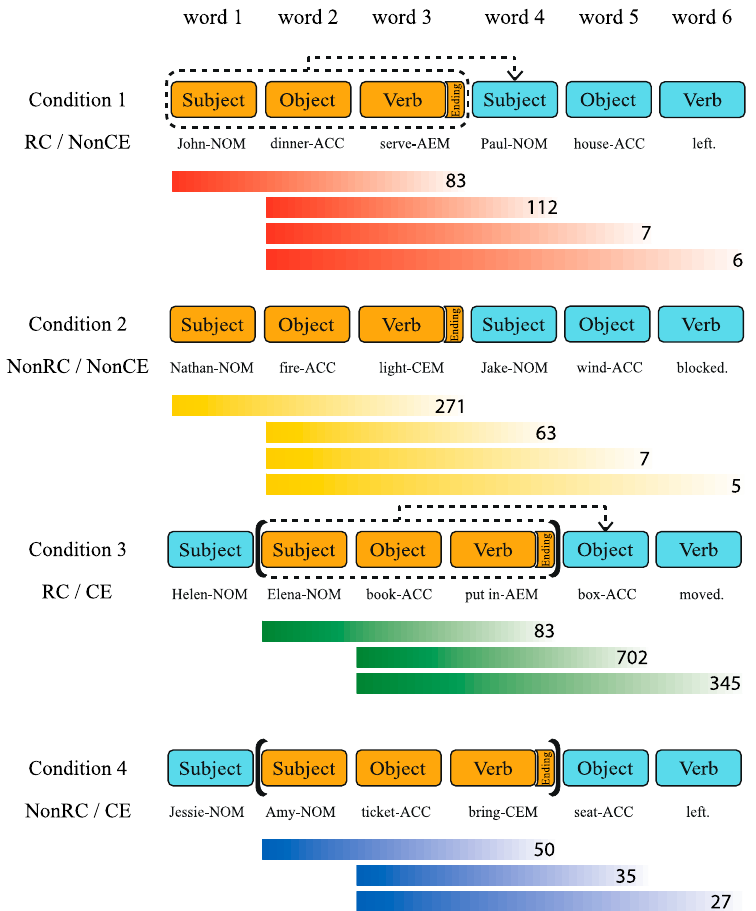
Figure 5. The partial structure frequencies of the stimuli. The number at the right end of the color gradient indicates the frequency of the partial structure (i.e., a set of words covered by the length of the color gradient) occurring in the corpus. For example, “83” in Condition 1 indicates that the structure of (subject + object + verb-AEM) appeared 83 times in the corpus [60]. The first values for Condition 2 and 4 are not identical because morphologically different endings were used. Not every partial structure was used to determine the relative difference in surprisal because only the structures with the same starting position can be compared. The Sejong Semantically Tagged Corpus of the Modern Korean with 797,251 sentences were analyzed by Hanmaru 2.0, a concordance program developed together with the corpus itself, to calculate partial structures of the sentence stimuli.